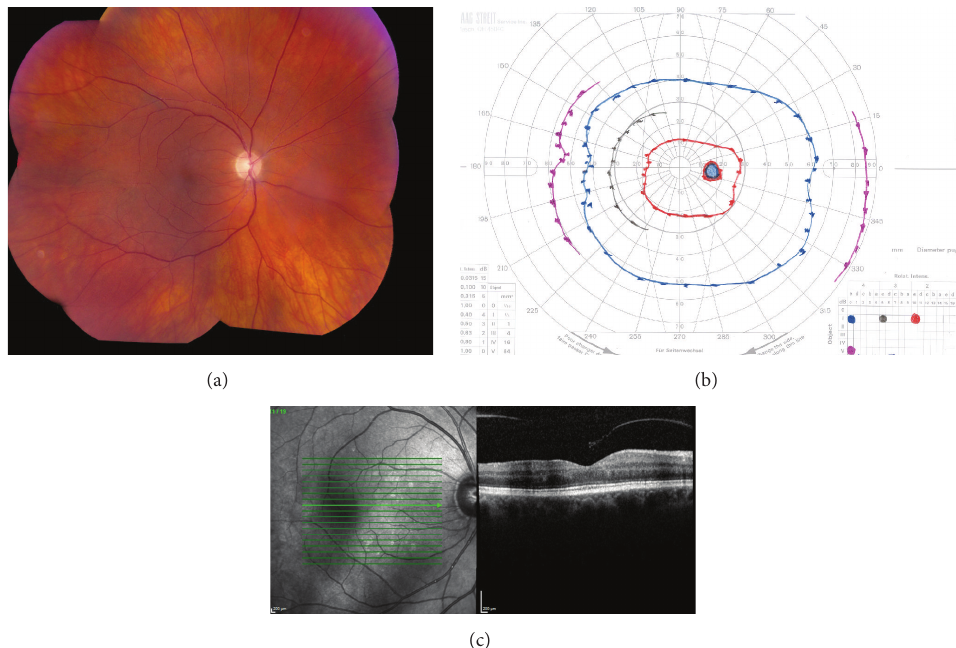
Figure 2: Resolution of ischemic retinal vasculitis after eight weeks. Color fundus montage photograph shows posterior pole arteriolar sheathing with attenuation in the retinal periphery (a). Goldmann visual field shows resolution of previous visual field defects (b). Optical coherence tomography is stable compared to previous with adequate representation of all retinal layers (c). The left eye was never